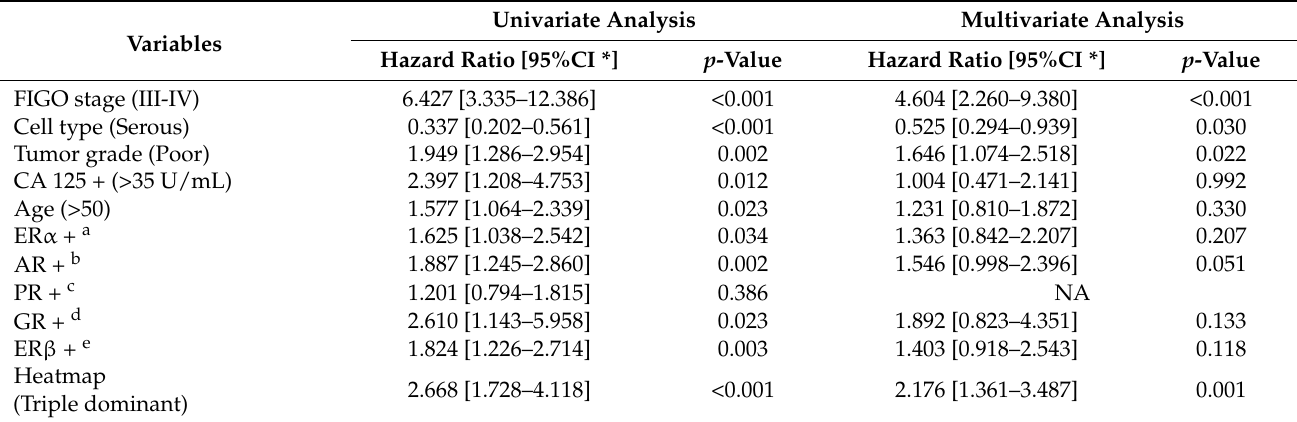
Table 1. Univariate and multivariate analyses of the association between prognostic variables and disease-free survival rates in epithelial ovarian